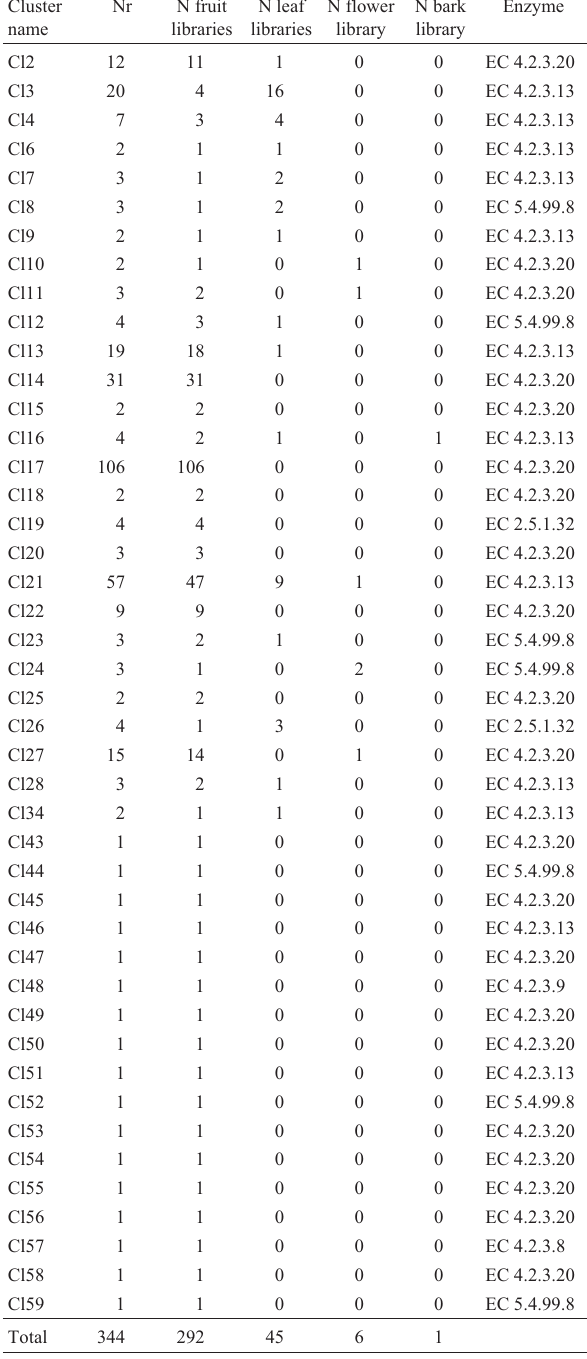
Table2 -Clustersofterpenesynthasegenes.Theclusterscontainingreads from the fruit libraries were analyzed in relation to the number of reads and their composition as well as to the class of enzyme they encode. EC